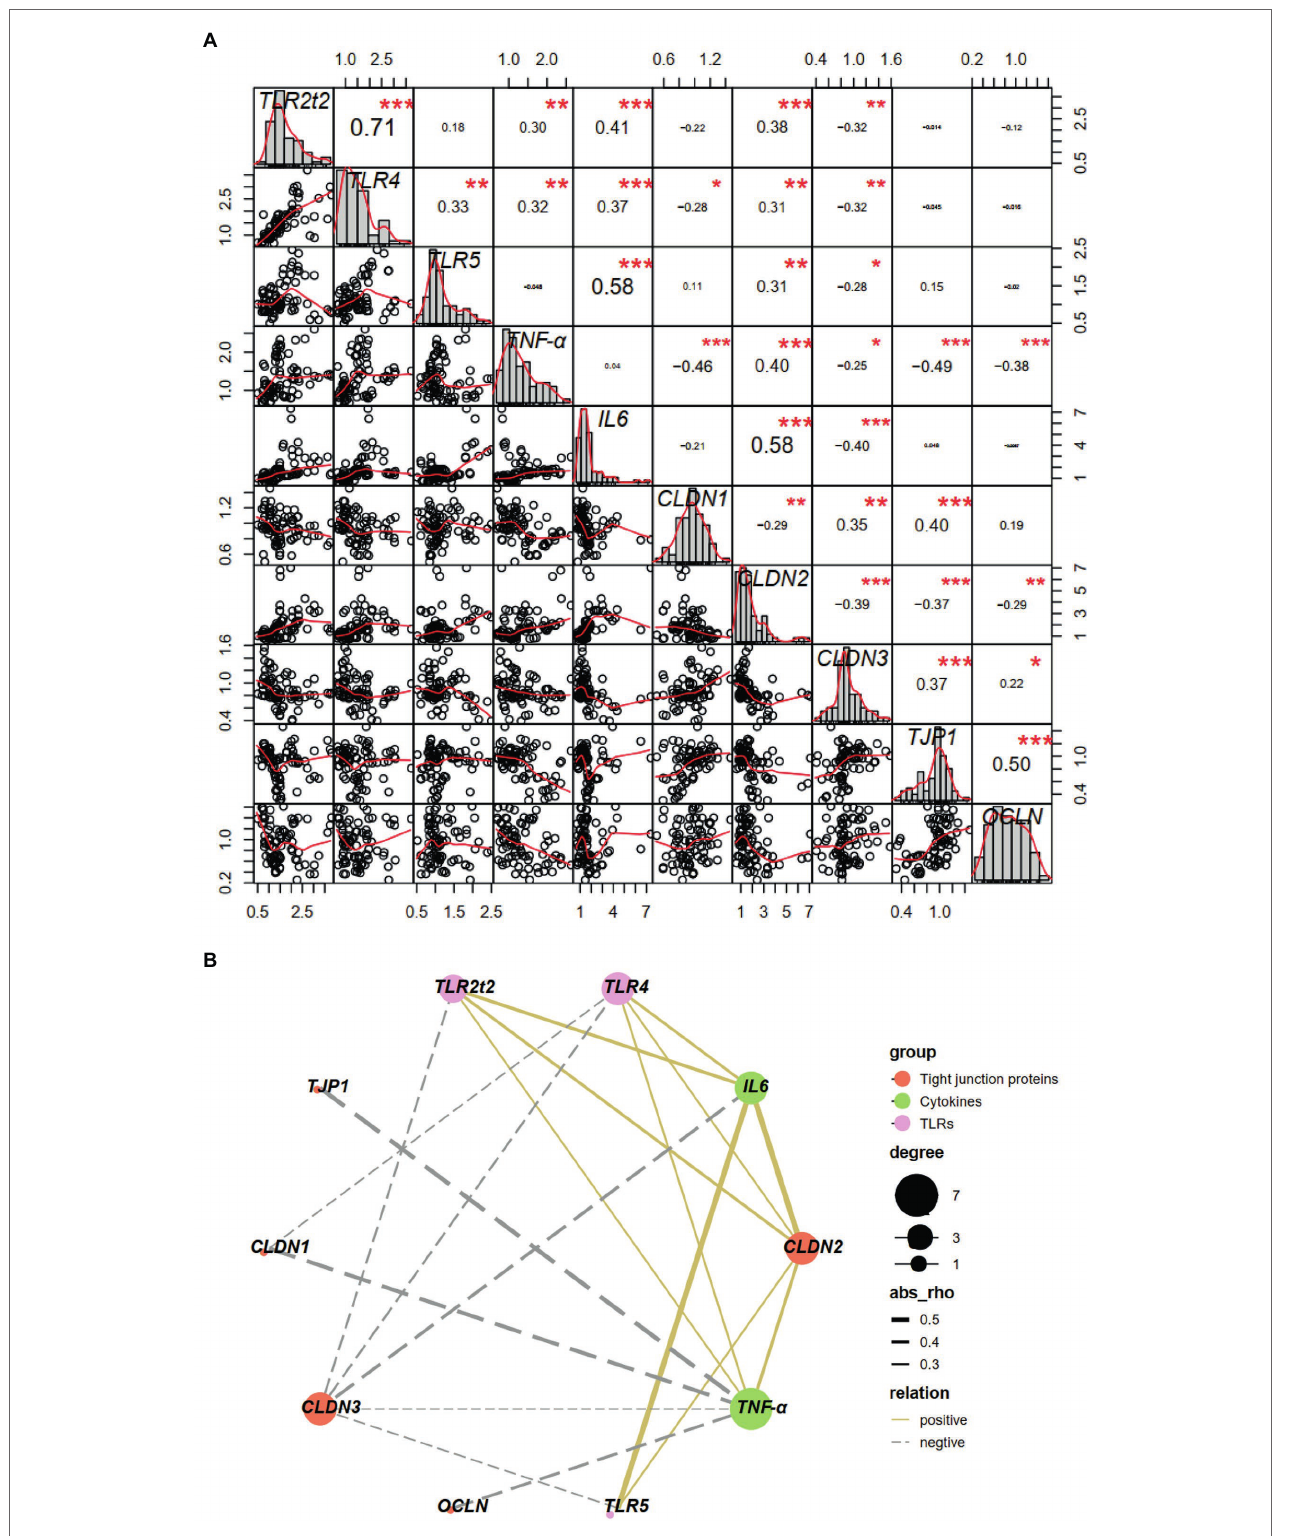
FIGURE 11 | Correlation between toll-like receptors and proinflammatory cytokines and tight junction proteins based on Pearson correlation analysis (A) and correlation network analysis (B) . ∗ p < 0.05, ∗∗ p < 0.01, ∗∗∗ p < 0.001. CLDN, claudin; OCLN, occludin; TJP, tight junction protein; TLRs, toll-like receptors; TNF, tumor necrosis